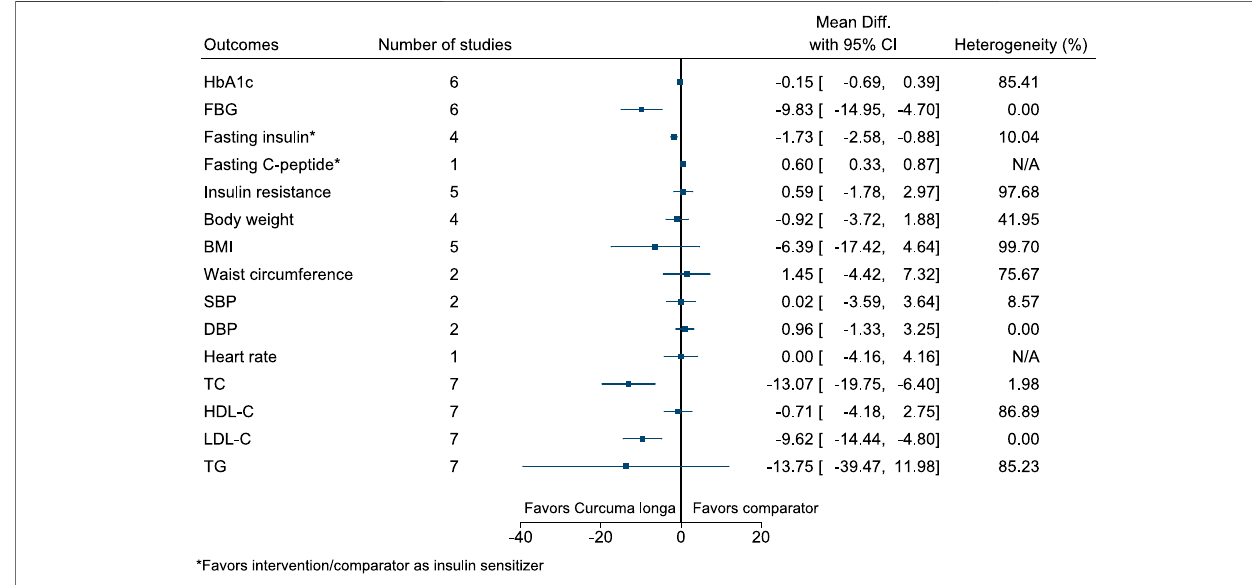
FIGURE 15 | Curcuma longa — Summary forest plot.